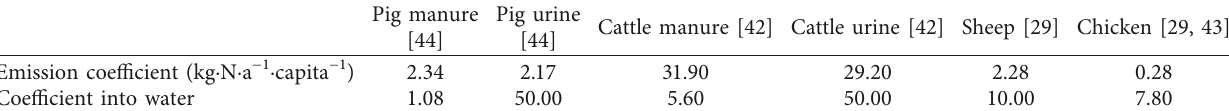
Table 2: Different N produced and loss coefficients by